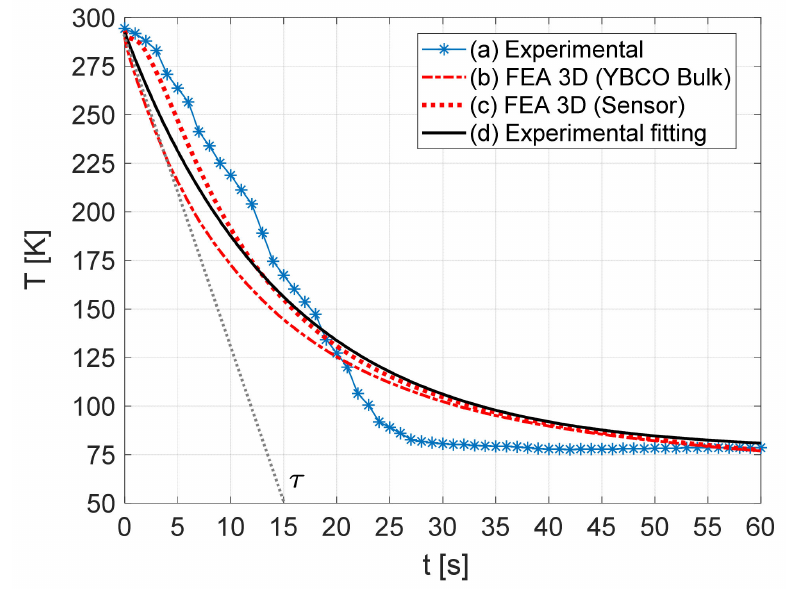
Figure 10. Evolution of the YBCO bulk